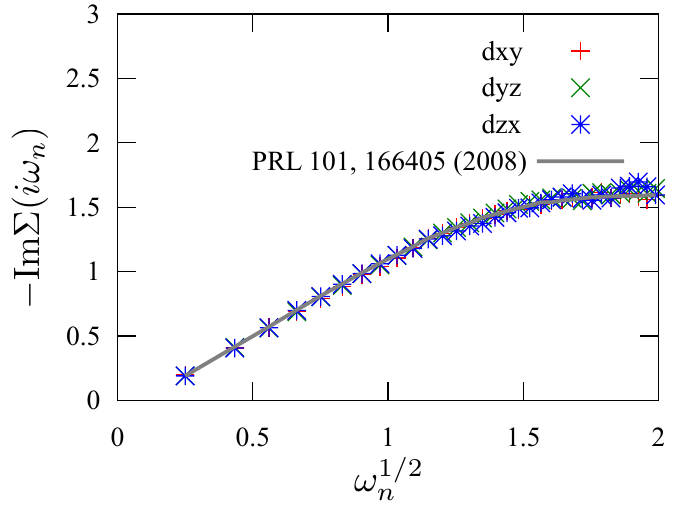
) . The solid line indicates n